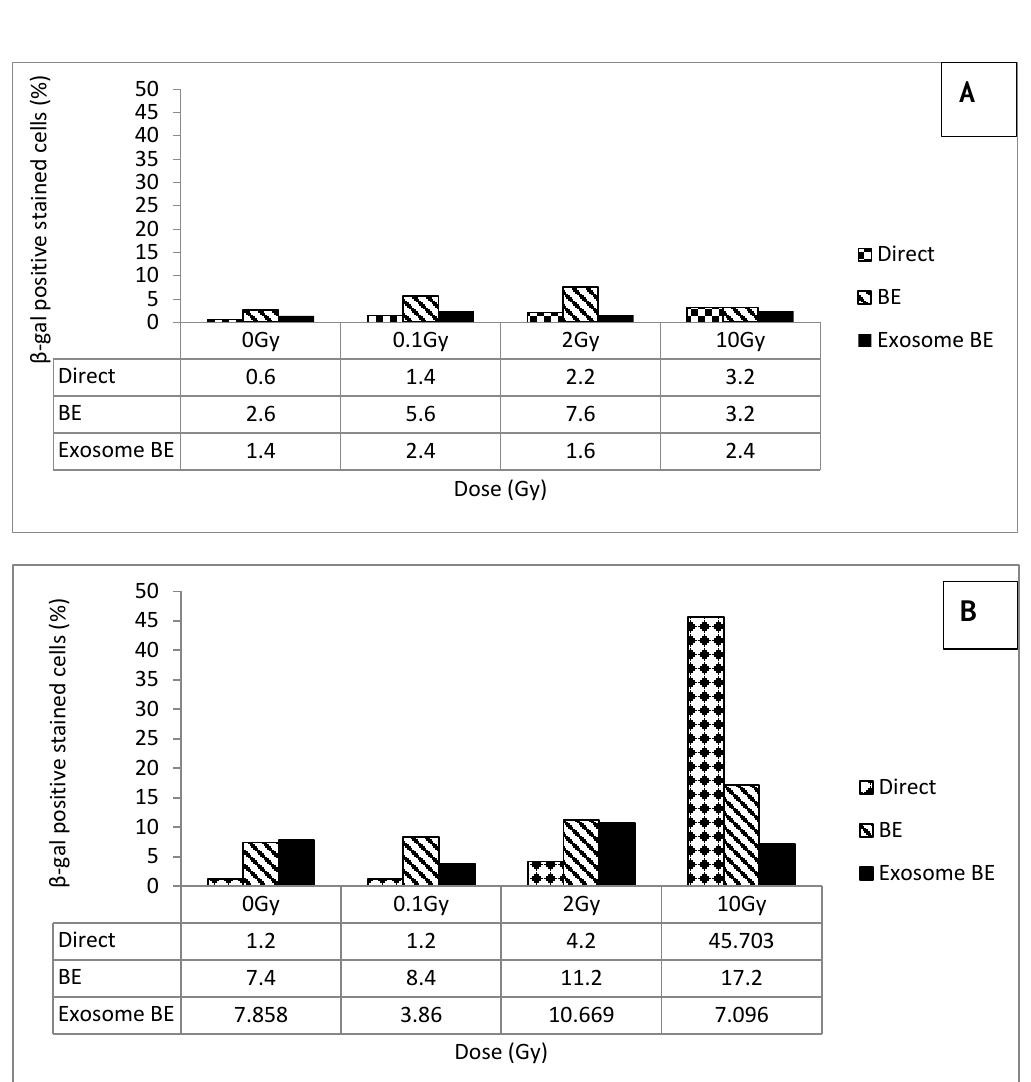
activate a senescence pathway in some of the cells. Exosome transfer had a similar effect, although in some cases less pronounced, senescence-inducing effect than in media transfer.